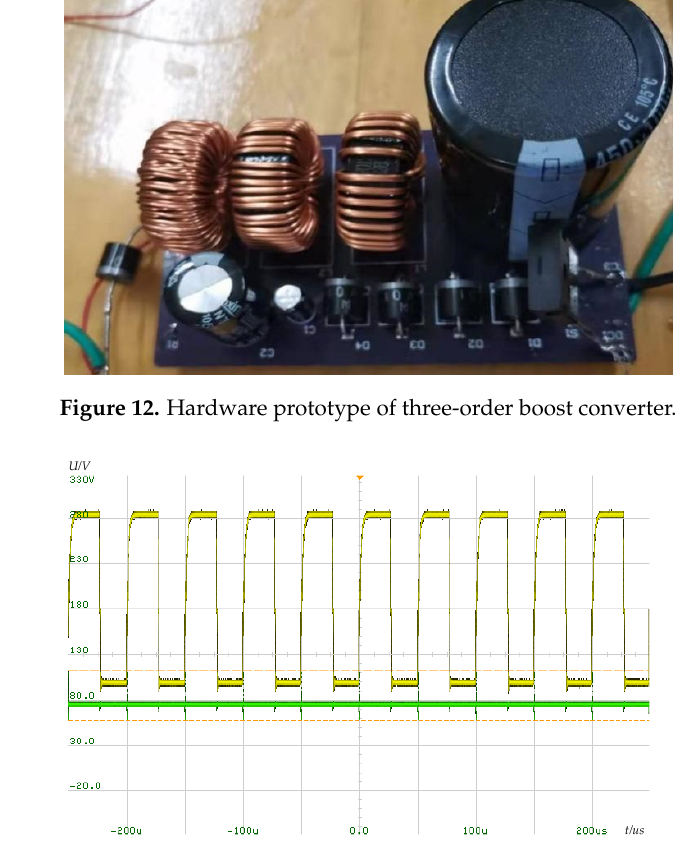
Figure 13. PWM control signals and output voltage of three-order boost converter.